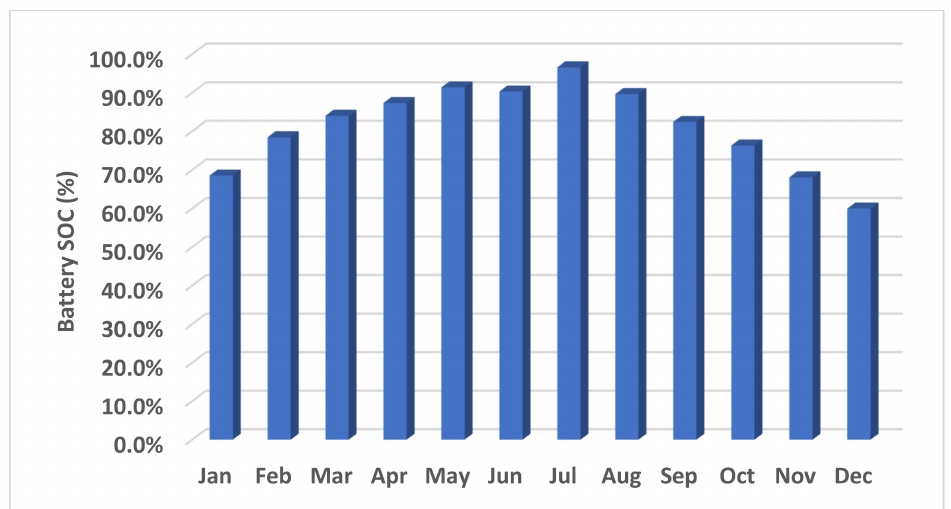
Figure 12. The monthly average battery state of charge (SOC) for the optimum system.